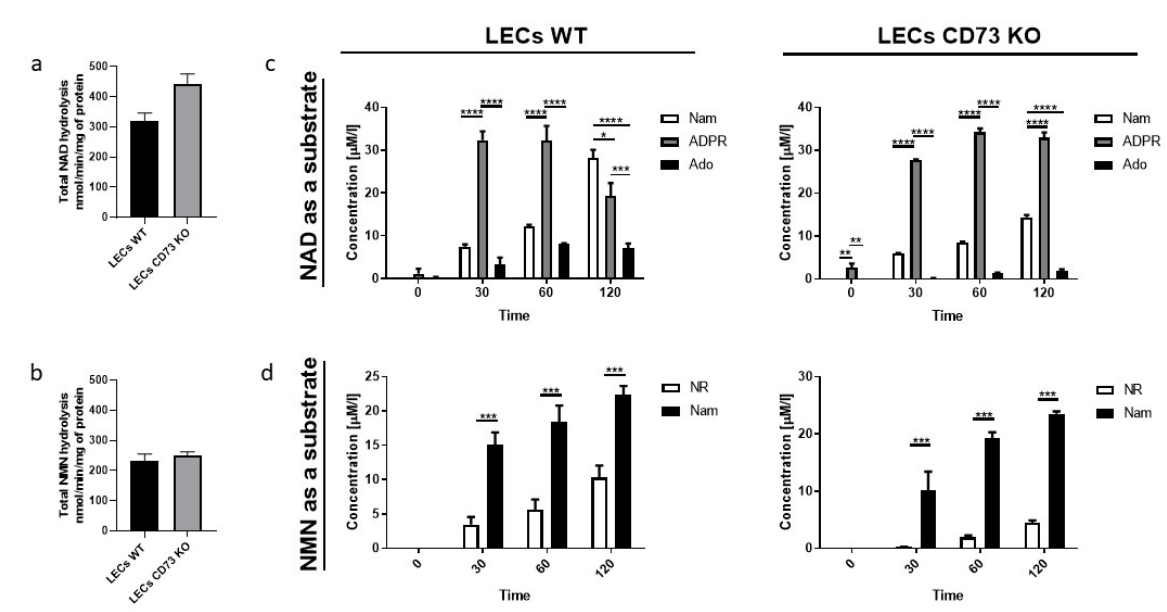
Figure 3. NAD + and NMN metabolism are different on LECs isolated from WT mice and CD73 KO mice. Total NAD ( a ) and NMN ( b ) hydrolysis on LECs WT and LECs CD73 KO. Concentration of products after incubation with 50 μM NAD + ( c ) and 50 μM NMN ( d ) on the LECs WT and LECs CD73 KO. Results are presented as the mean ± SEM; n = 3–6. * p < 0.05, ** p < 0.01, *** p < 0.001, **** p < 0.0001 with two-way ANOVA followed by Bonferroni’s